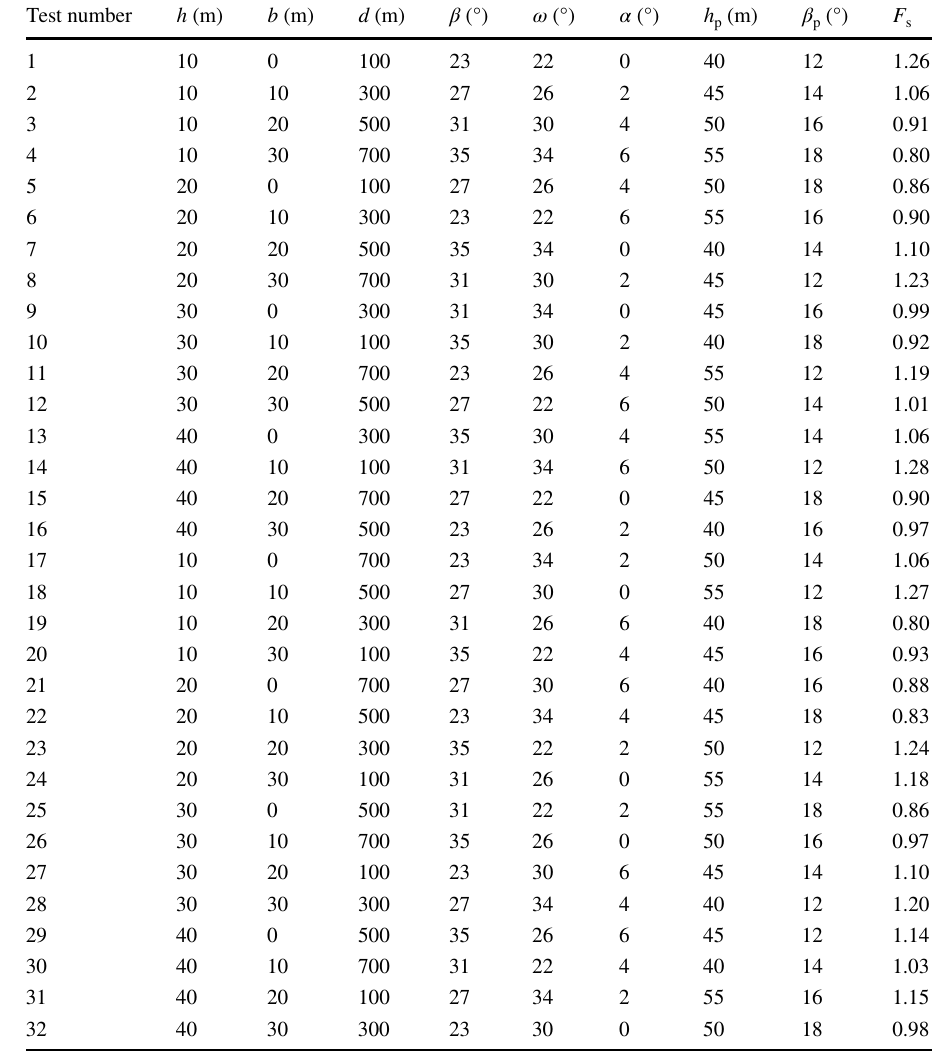
calculation results of inner dump stability